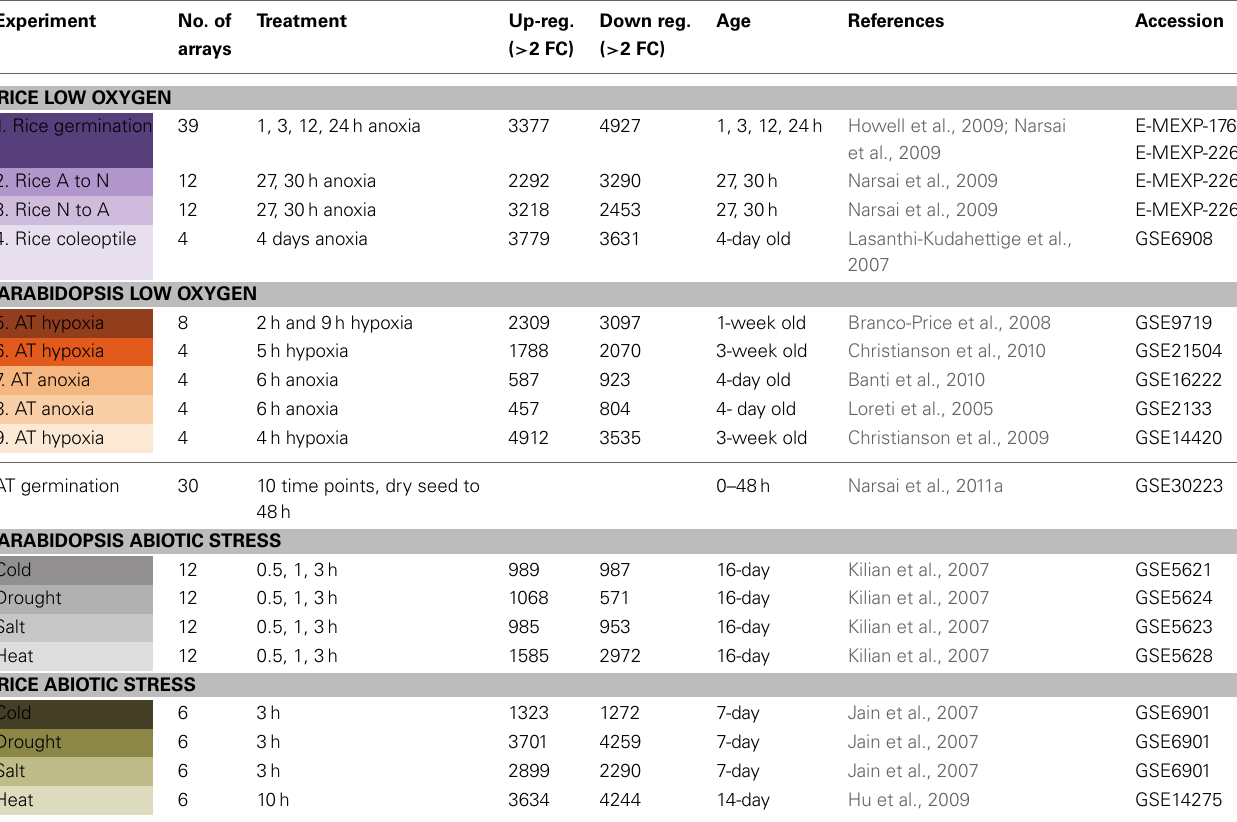
Table 1 | Microarray data used for